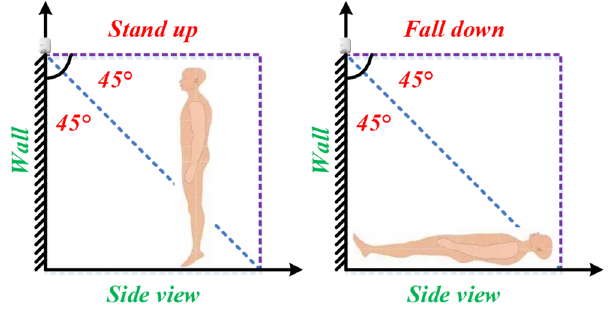
Figure 6. Side view of somebody standing up or falling down.